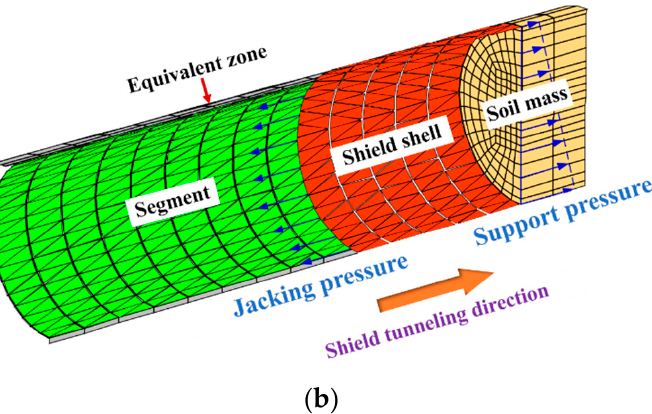
Figure 6. Numerical model of EPB shield. ( a ) Grid division diagram. ( b ) Local features of the model. Table 2. Calculation parameters of soil and equivalent zone.